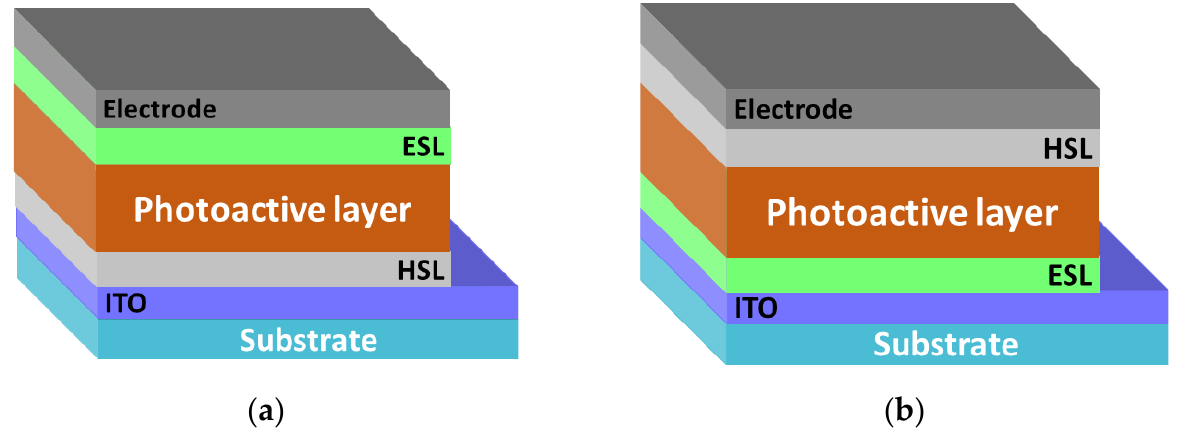
Figure 3. ( a ) Bulk heterojunction organic solar cells: standard configuration with the top electron- collecting electrode and ( b ) inverted configuration with the top hole-collecting electrode.